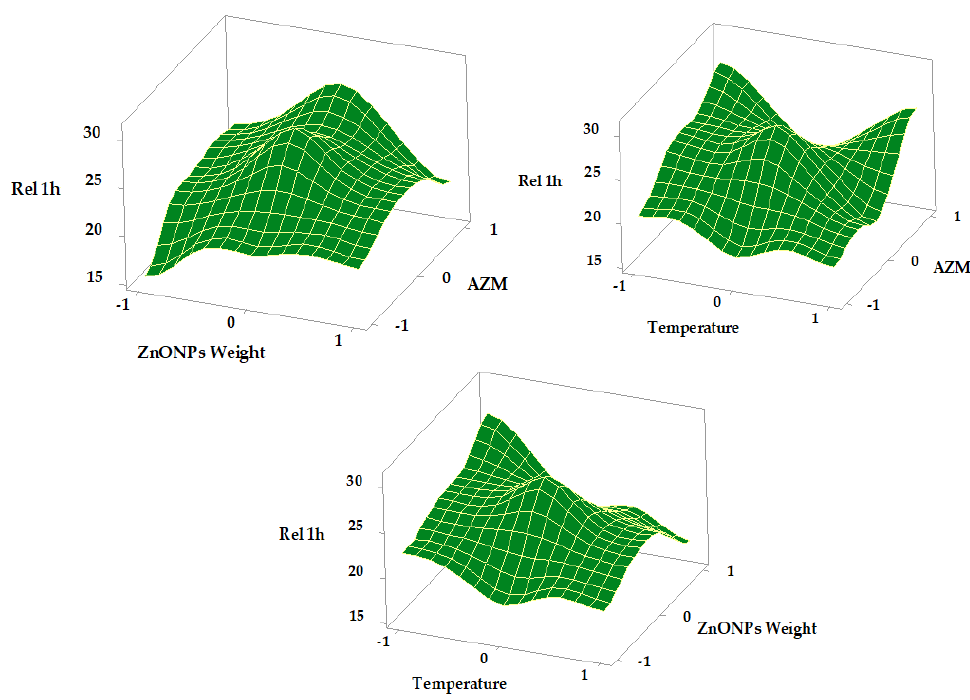
Figure 6. Surface plot effects of different formulation factors on release after 1 h.